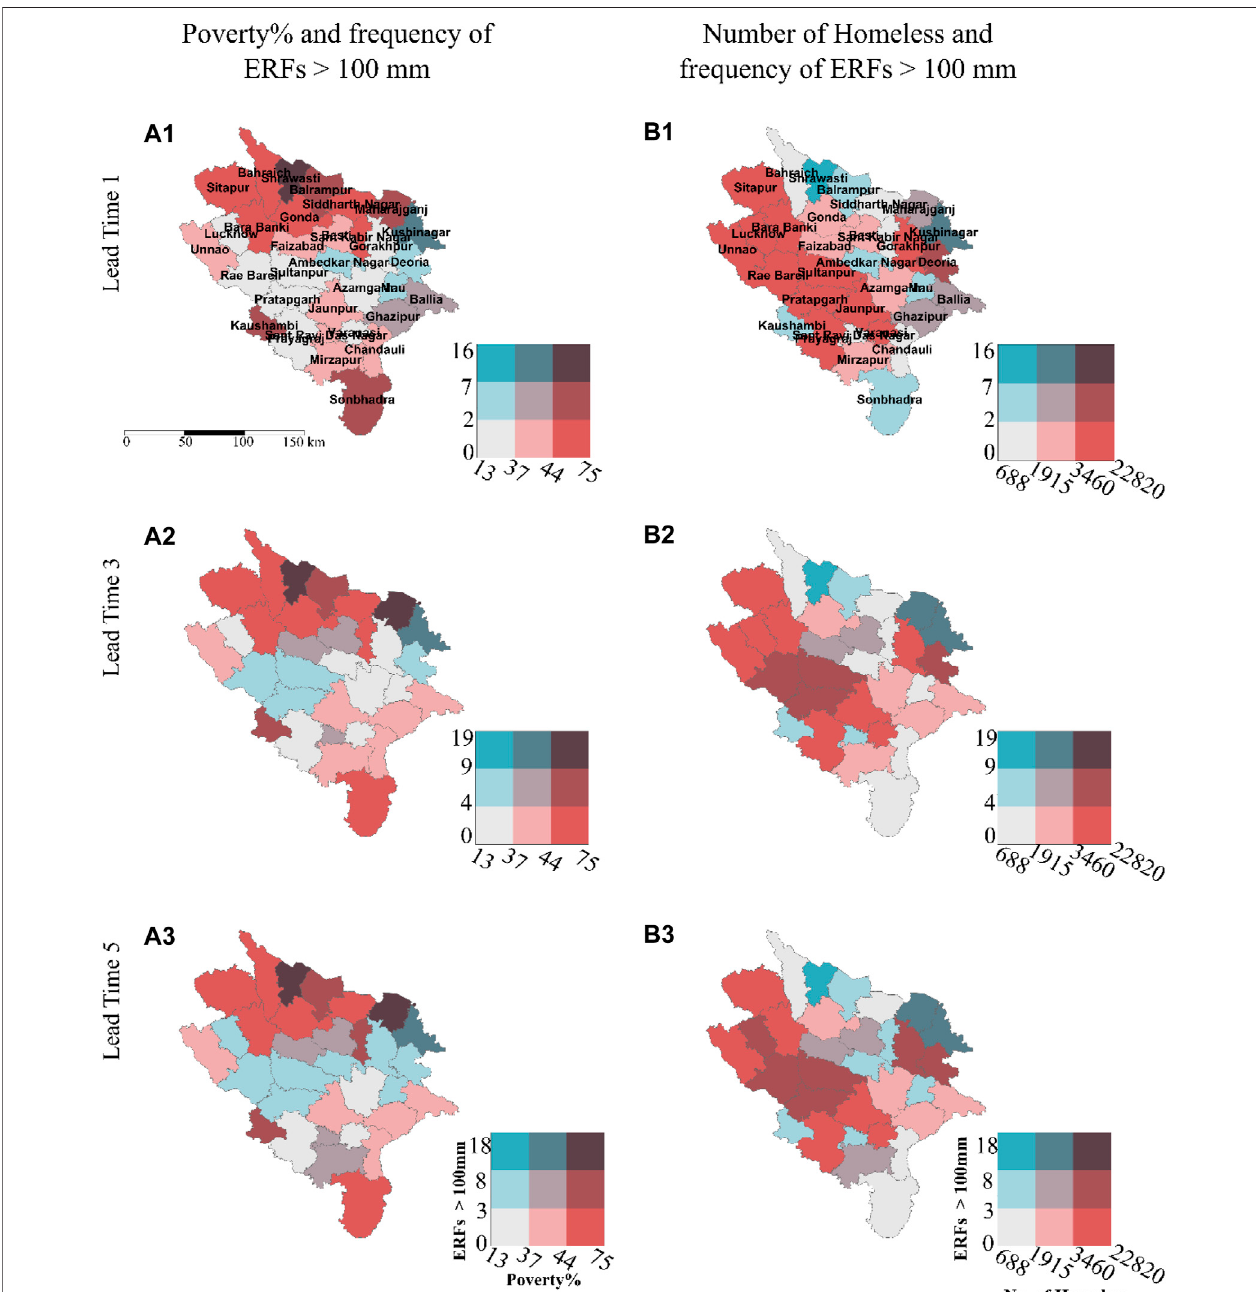
FIGURE 4 | A bivariate choropleth map showing the combined effect of the number of ERFs with the poor population (Panels (A1 – A3) ) and homeless population (Panels (B1 – B3) ) across the districts at three lead times and 100 mm threshold.